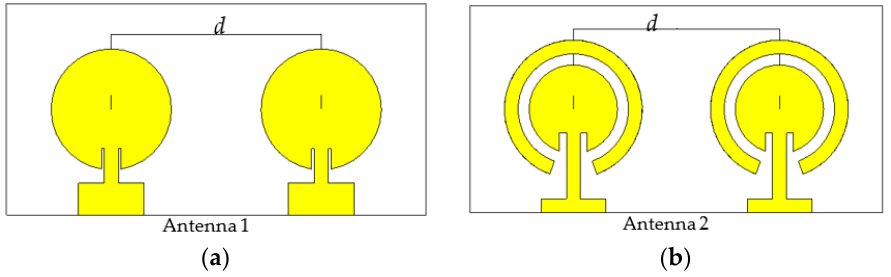
Figure 4. Two-element MIMO antenna ( a ) without parasitic elements (Antenna 1) and ( b ) with parasitic elements (Antenna 2).